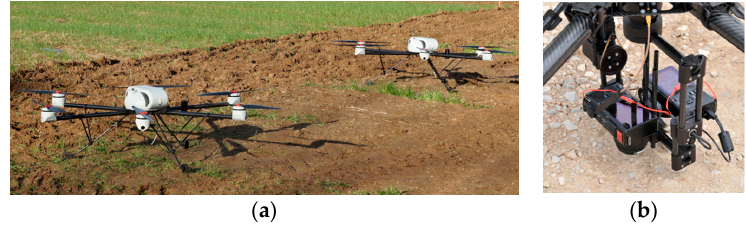
Figure 6. AR200 drones ( a ) with a detail of the camera mounting ( b ).